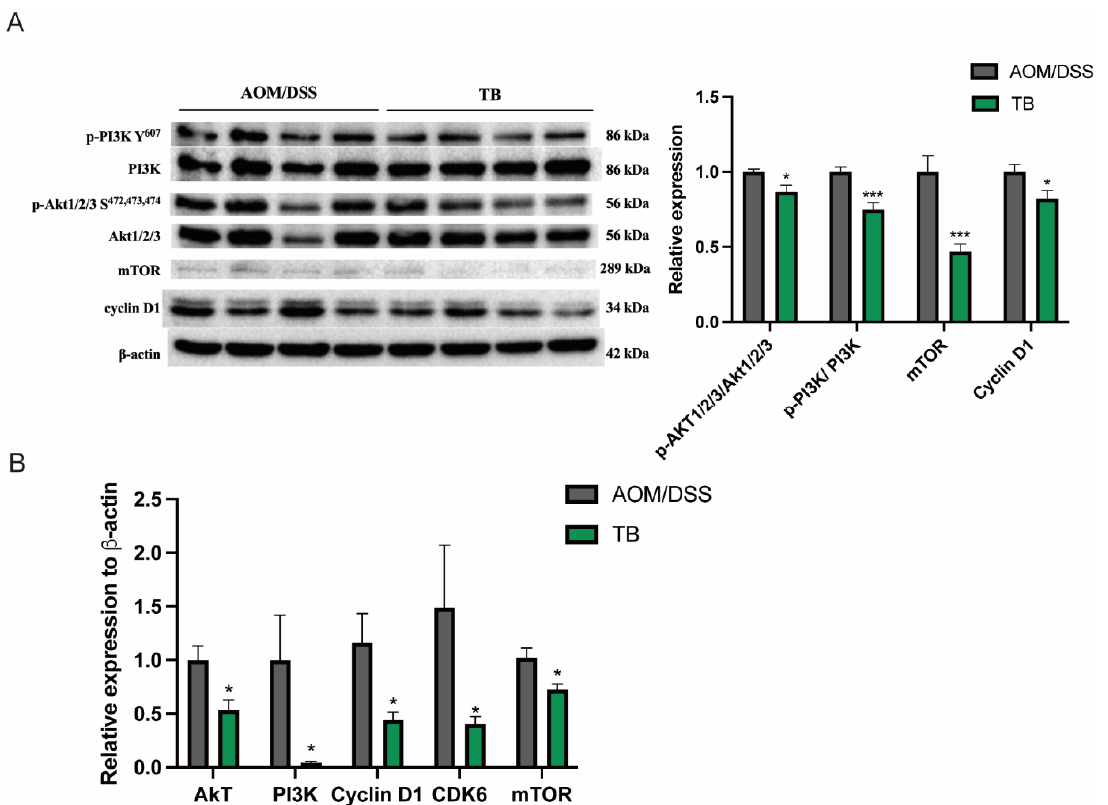
Figure 3. TB inhibits tumor growth through suppressing PI3K/Akt signaling pathway. ( A ) Protein expressions were quantified and normalized against β -actin. ( B ) mRNA expression of Akt, PI3k, Cyclin D1, CDK6, and mTOR was quantified by RT-PCR. n = 7–8 per group * p < 0.05, *** p < 0.001, compared to AOM/DSS.